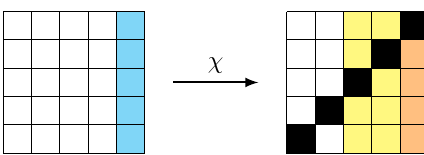
Figure 8: Fixing 5 bits on a slice before χ . The blue bits are fixed so as to linearize the expression of yellow bits. The orange bits are equal to the blue bits with probability 0 . 75. The black bits are not of